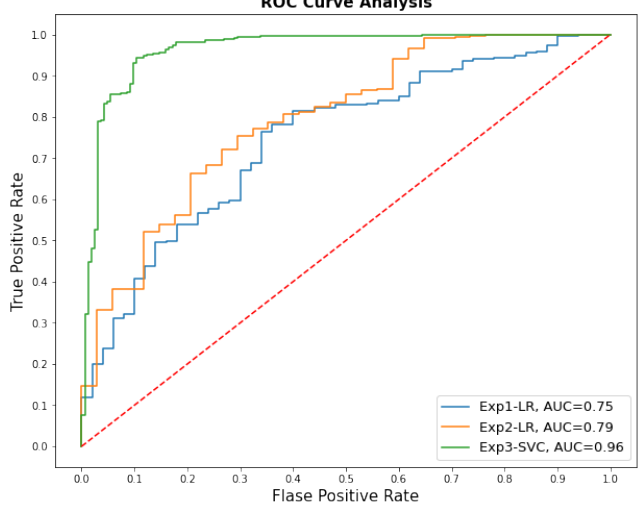
Figure 7. Plot of the three experiments ROC curve